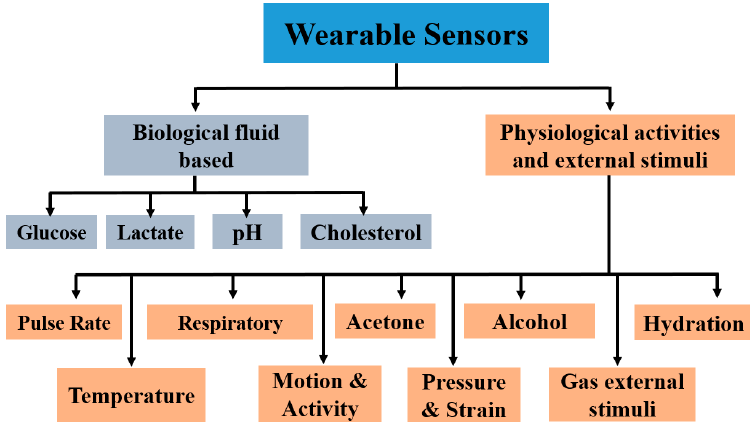
Figure 5. Block diagram of representative and prominent wearable sensors covered in this review